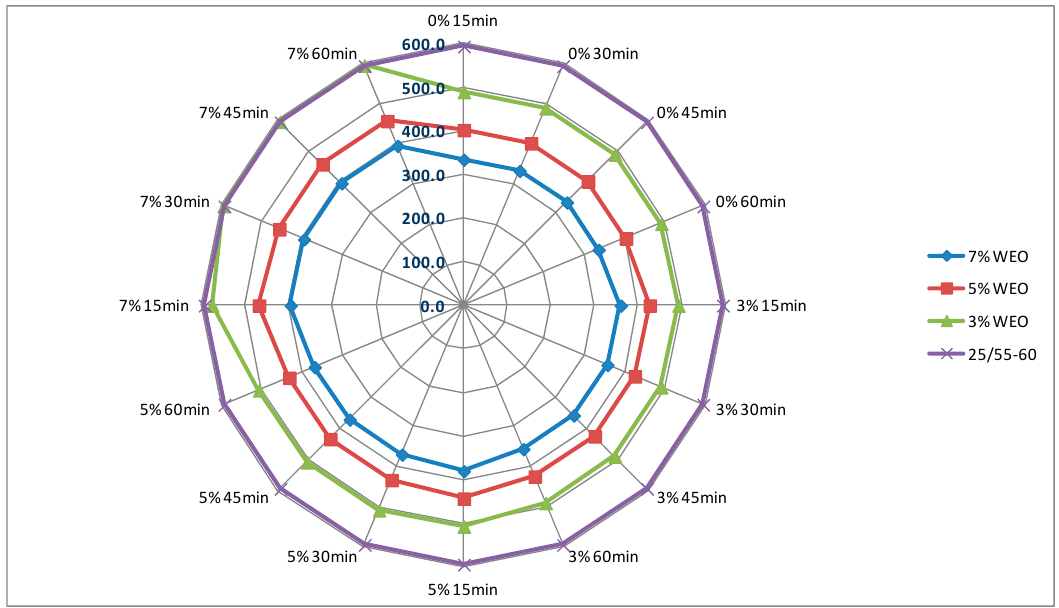
Figure 6. The results of dynamic viscosity tests for the 25/55-60 asphalt with the addition of WEO and the Na-P1 zeolite measured at 160 °C (mPa·s).